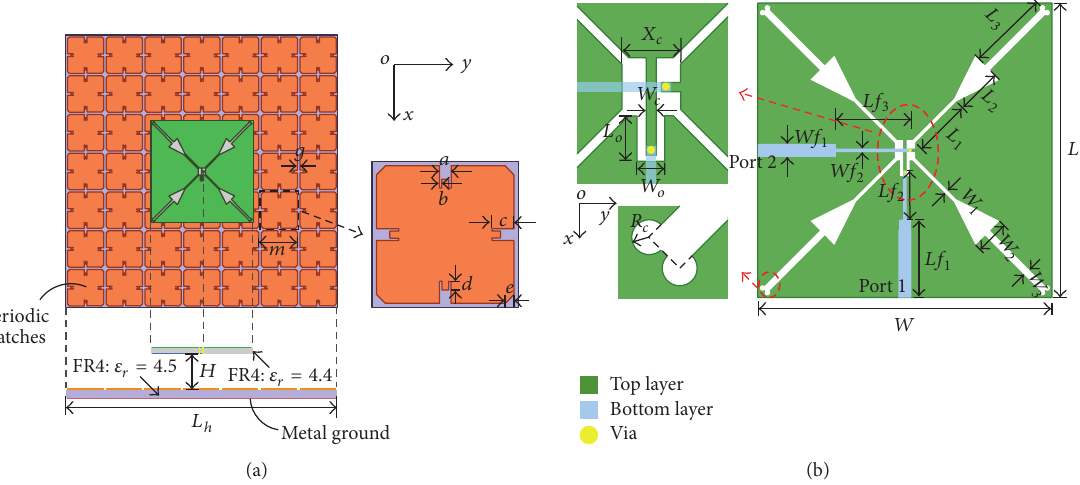
Figure 1: Geometry of the proposed dual-polarized antenna. (a) Top and side views and (b) dual-polarized slot antenna.